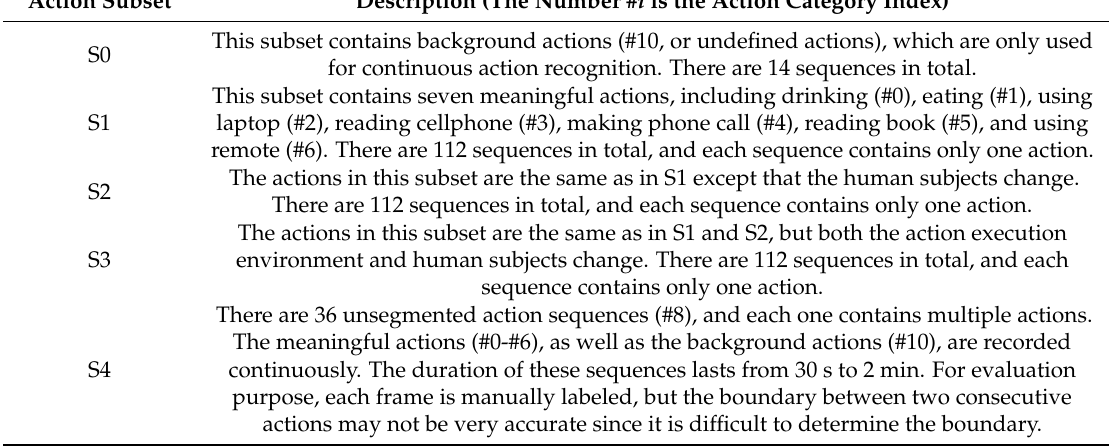
Table 1. MSR 3D Online Action dataset.